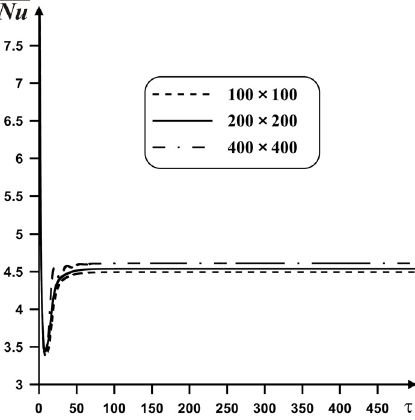
Figure 6. Time profiles of average Nu for various mesh parameters.